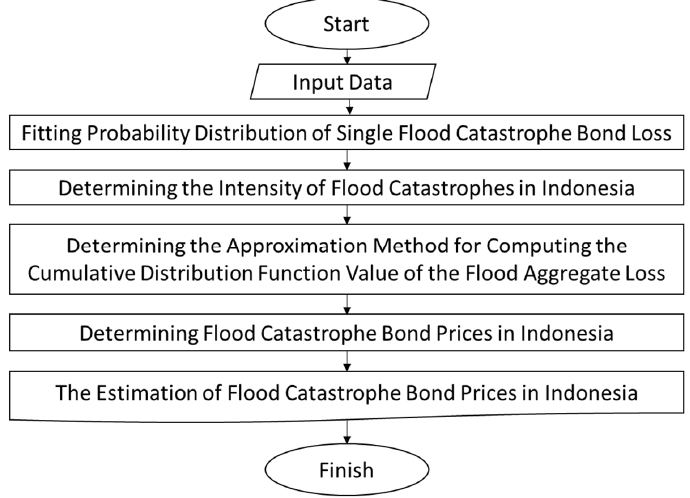
Fig. 1 . The FCB Price Estimation Steps in